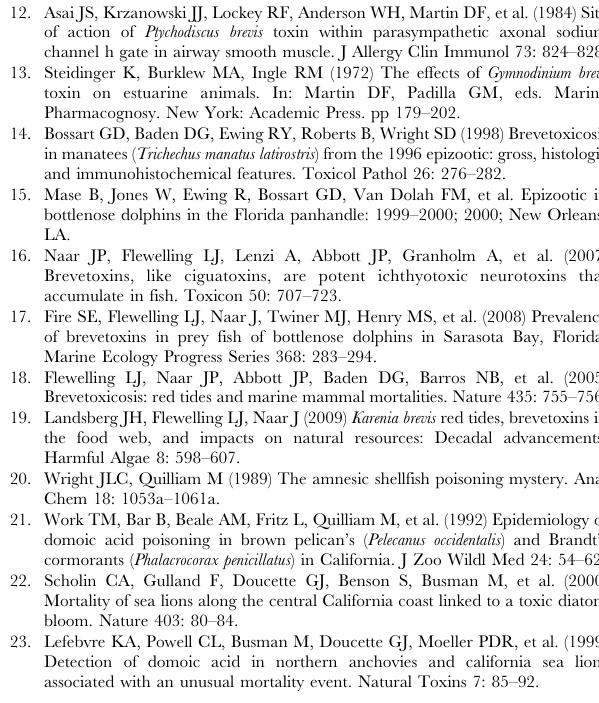
Table S1 Concentration of brevetoxin (ng/mL or ng/g) in various animal samples. Table S2 Concentration of domoic acid (ng/mL or